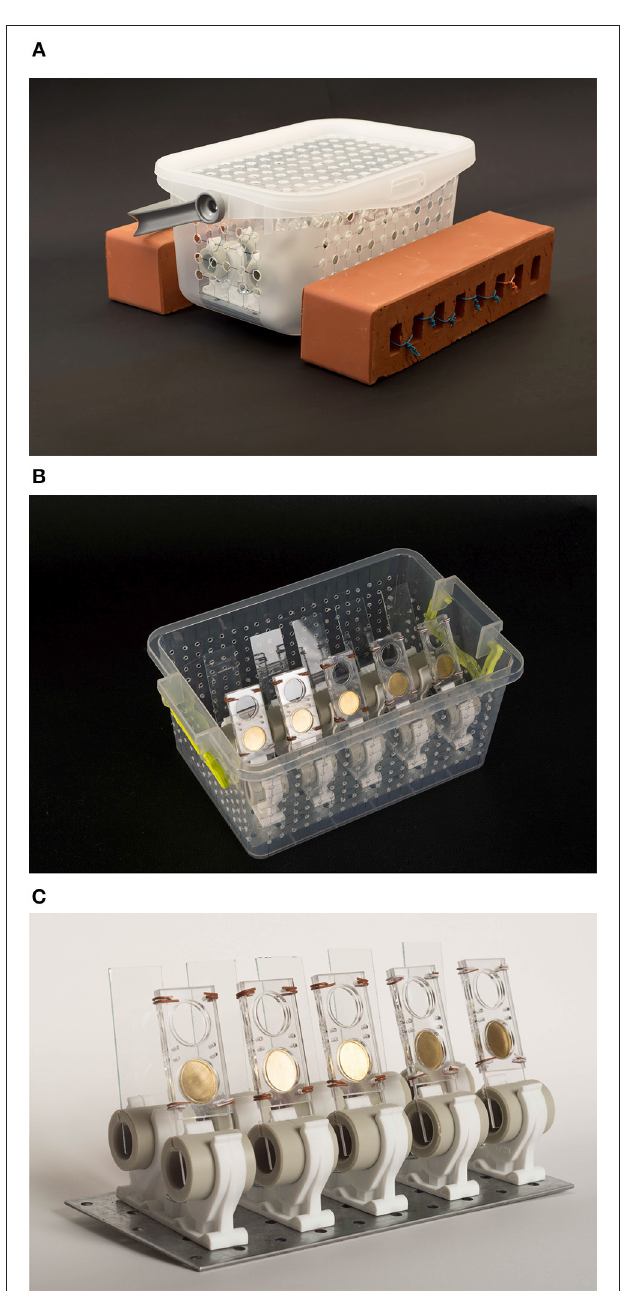
FIGURE 2 | Biofilm sampling devices: (A) loaded sampling substrata carrier ready to deployment; (B) perpendicularly-oriented rectangular plates or disks placed in a plastic box; (C) sampling substrata plastic holders.